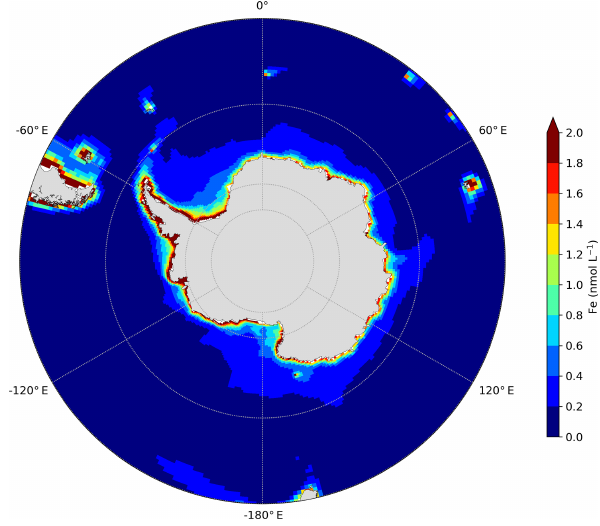
Figure 2. Annual mean of surface Fe concentrations in the Southern Ocean, south of 45 ◦ S, in the CTL